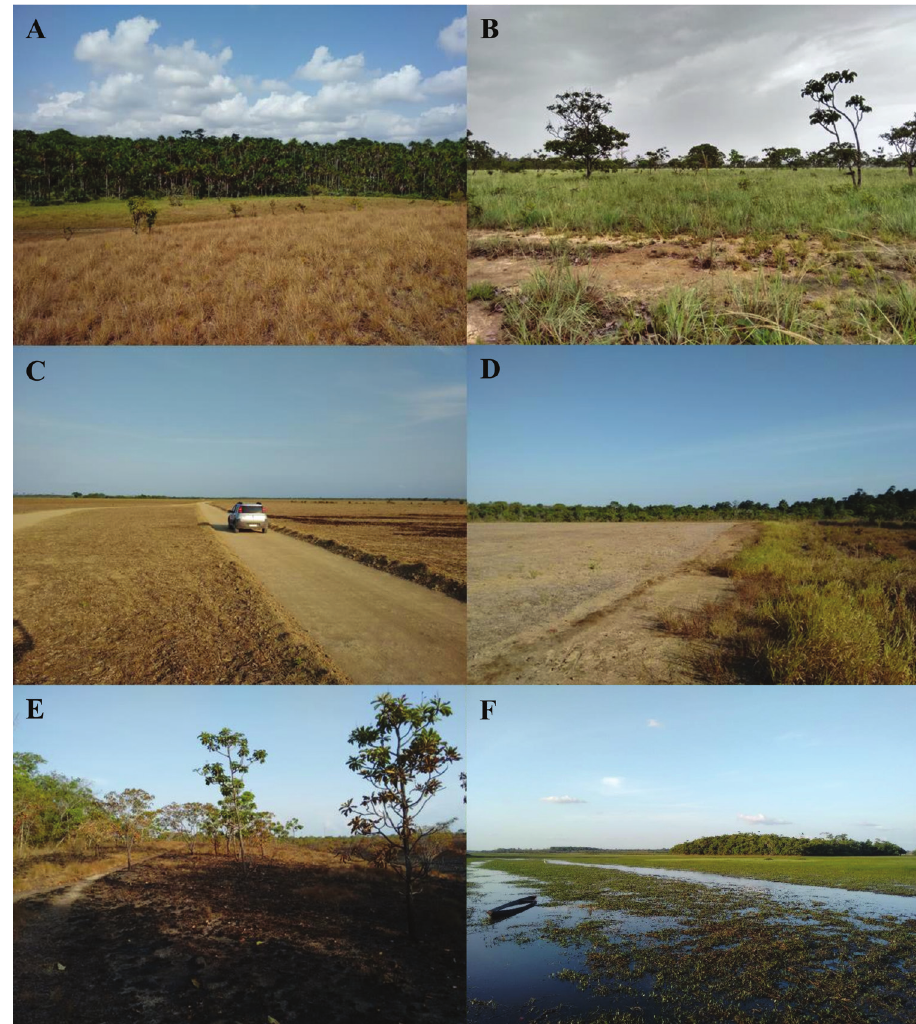
Figure 2. Images of habitat types and soybean plantations in the Cerrado of Amapá. A Grass savanna with gallery forests in the background, showing characteristic presence of palms B Area of park savanna C Area of park savanna converted to plantations of soybeans and maize D The right-hand side of the image shows what is left of an area of park savanna, the left-hand side shows an area prepared for planting with soybeans and maize, and in the background are natural forest fragments that occur within the Cerrado of Amapá E An area of park savanna after being burned; and F flooded savanna with grass savannas and a natural forest fragment